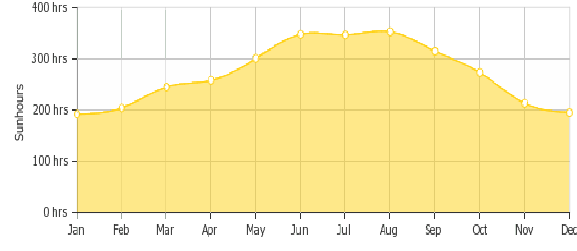
Figure 3. Monthly mean sunshine hours [16].